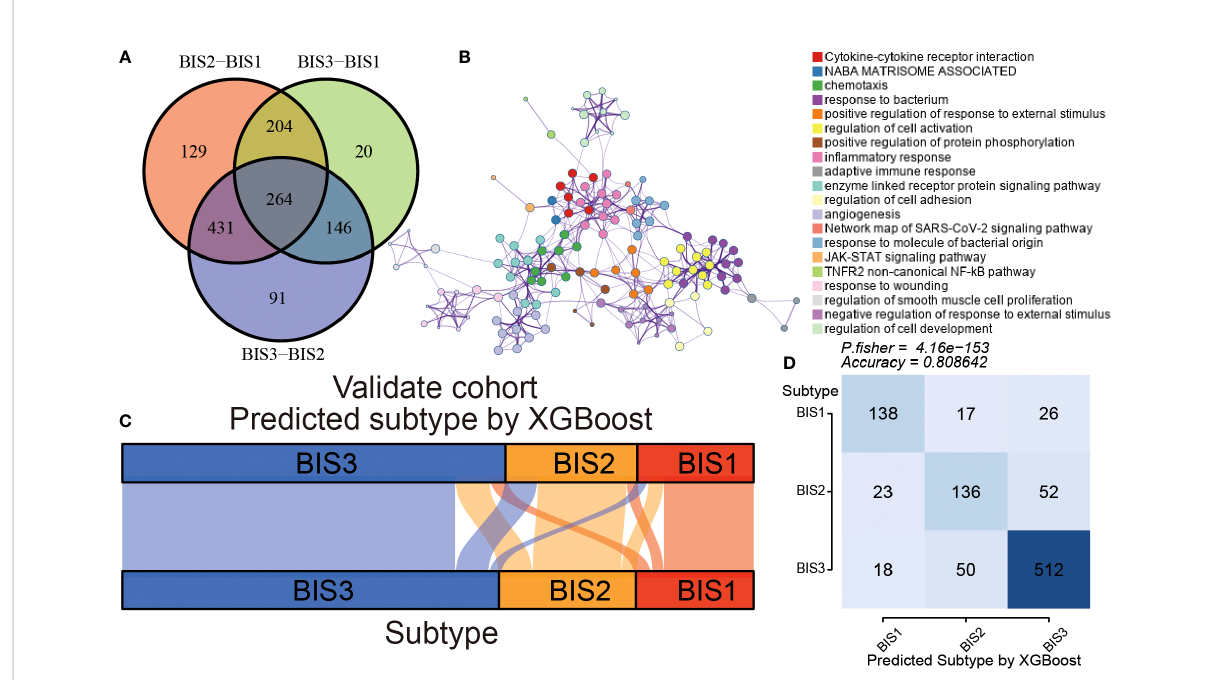
FIGURE 7 Construction and validation of an immune subtype classi fi er. (A) Venn diagram showing differential expression of immune-related gene between three subtypes in TCGA BLCA cohort. (B) The Metascape analysis of differential expression of immune-related genes. The alluvial diagram (C) and Fisher ’ s test (D) of three subtypes samples in the validation